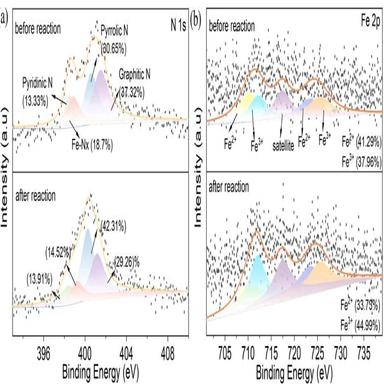
The N1s (a) and Fe2p (b) XPS spectra of EMFe0.2S before and after catalysis reaction.